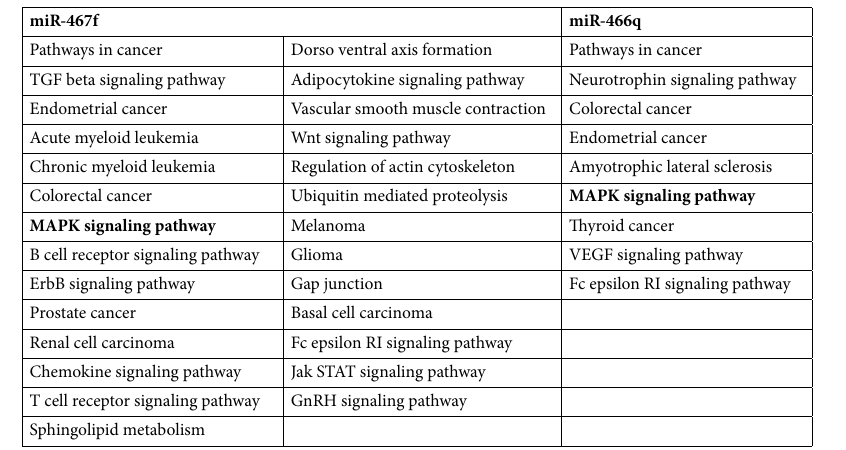
Table 1. Pathways predicted to be affected by miR-467f and miR-466q.